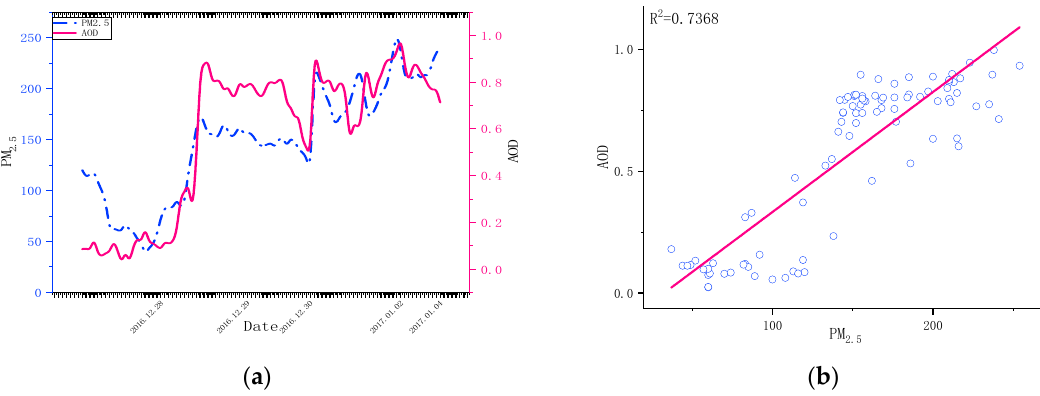
Figure 9. Relationship between particulate matter and the aerosol optical depth (AOD): ( a ) Variation in AOD and the concentration of particulate matter; ( b ) correlation between the concentration of particulate matter and AOD.